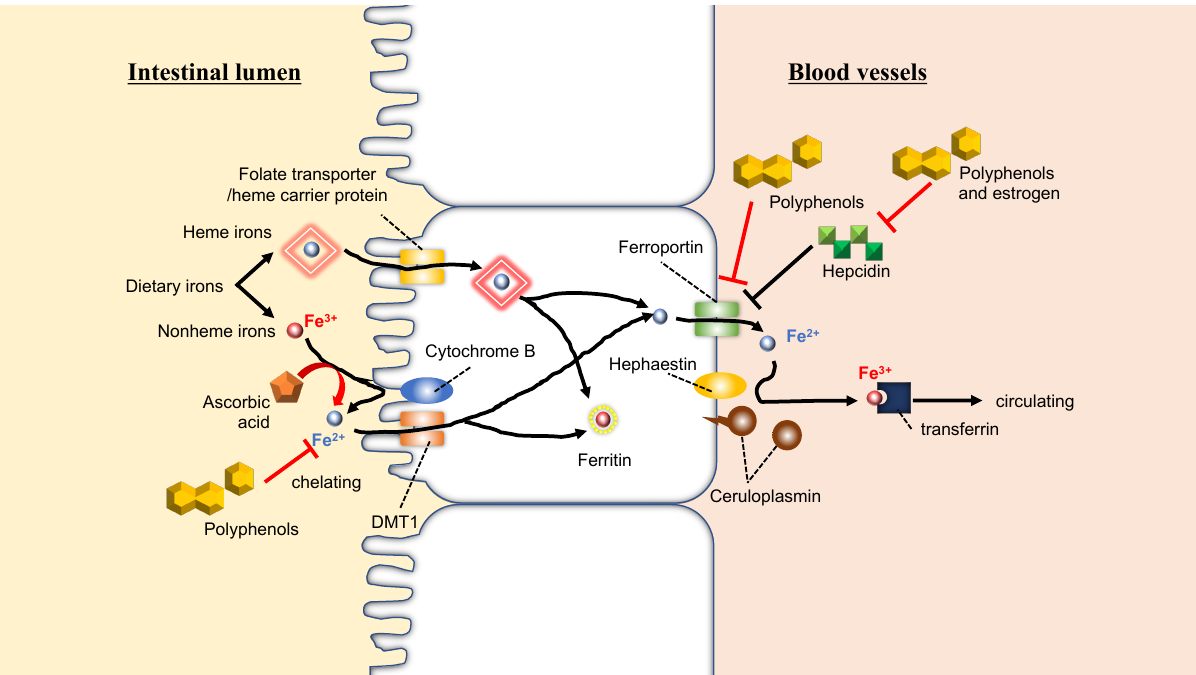
Figure 2. Absorption behavior of iron in the intestine and the interaction with molecules derived from food (modified with permission from [50] under the Creative Commons CC BY 4.0 license, https://creativecommons.org/licenses/by/4.0/ (accessed on 28 July